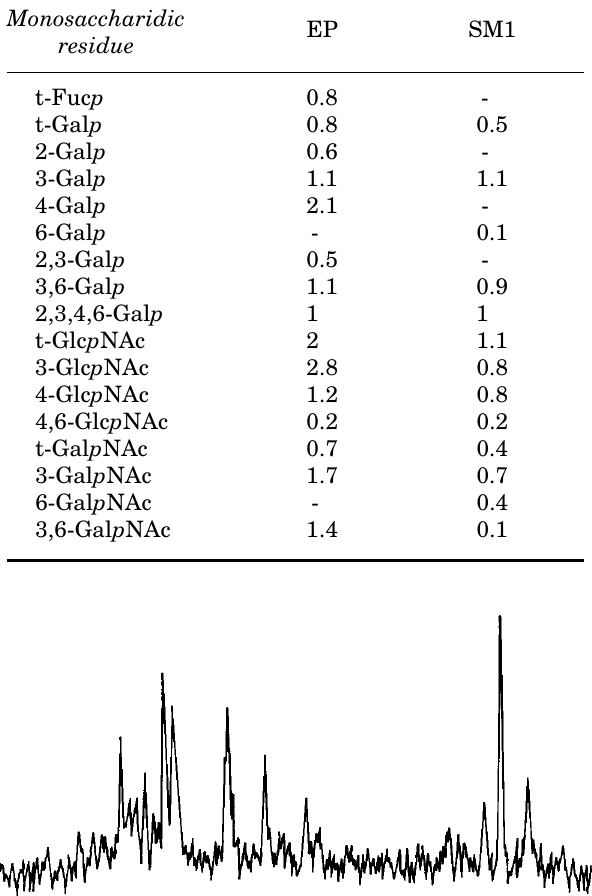
Table 1. Interglycosidic linkages and molar ratios among residues for EP and SM1 Smith degraded polysaccha-